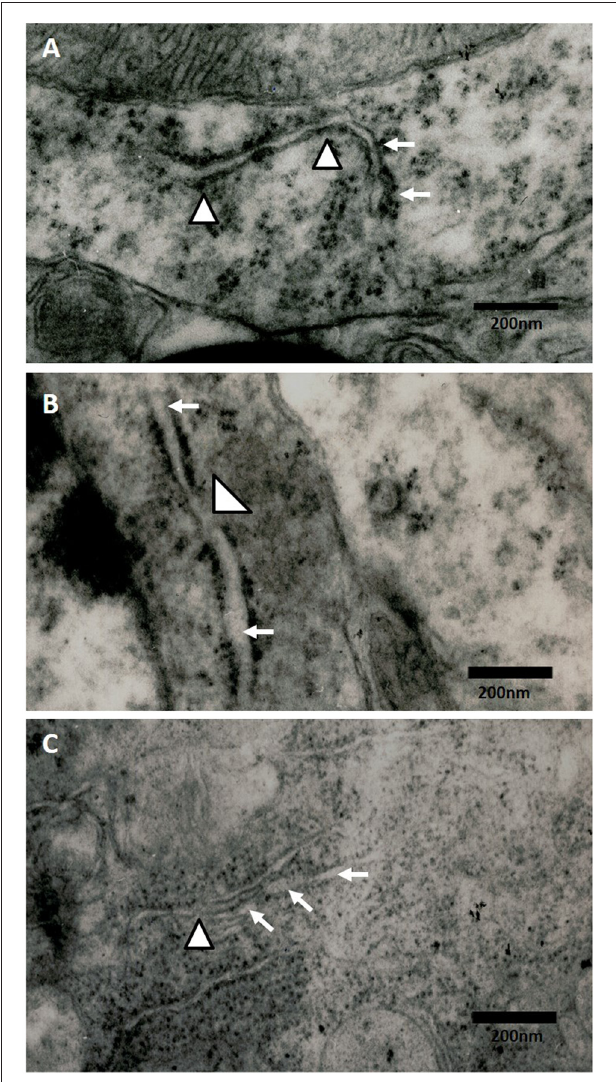
FIGURE 5 | Effect of chronic exposure to ozone on endoplasmic reticulum (ER) in rat hippocampus. Electron micrographs of rat hippocampus exposed to ozone. (A) Control, (B) 60D, (C) 90D. (A) The micrograph shows the ER of normal appearance with associated ribosomes. (B,C) show damage and swelling of ER (broad arrow) and loss of continuity in the membranes of ER (arrowhead) after 60 days and 90 days of exposure to ozone 40,000 ×